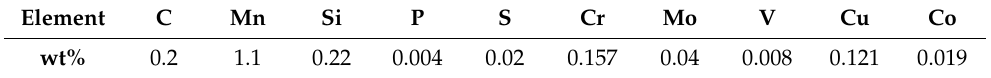
Table 1. Chemical composition of the low-carbon steel used for validating the PF model. Element